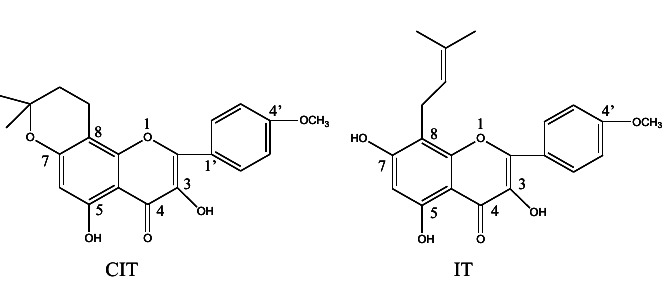
Figure 1. Chemical structures of CIT and